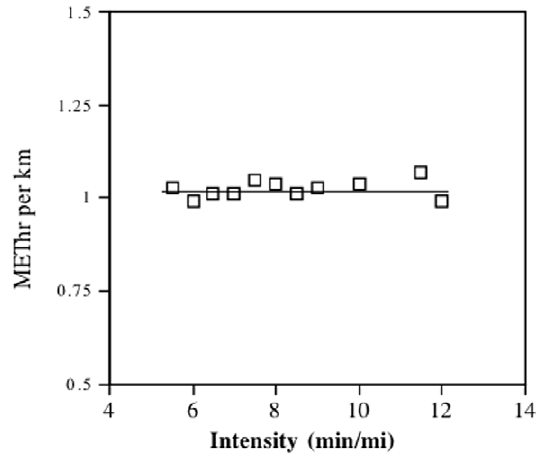
Figure 1. Metabolic equivalent hours per day (METhr/d) per km/d run from the published compendium values by Ains- worth et al [ 7 ] .